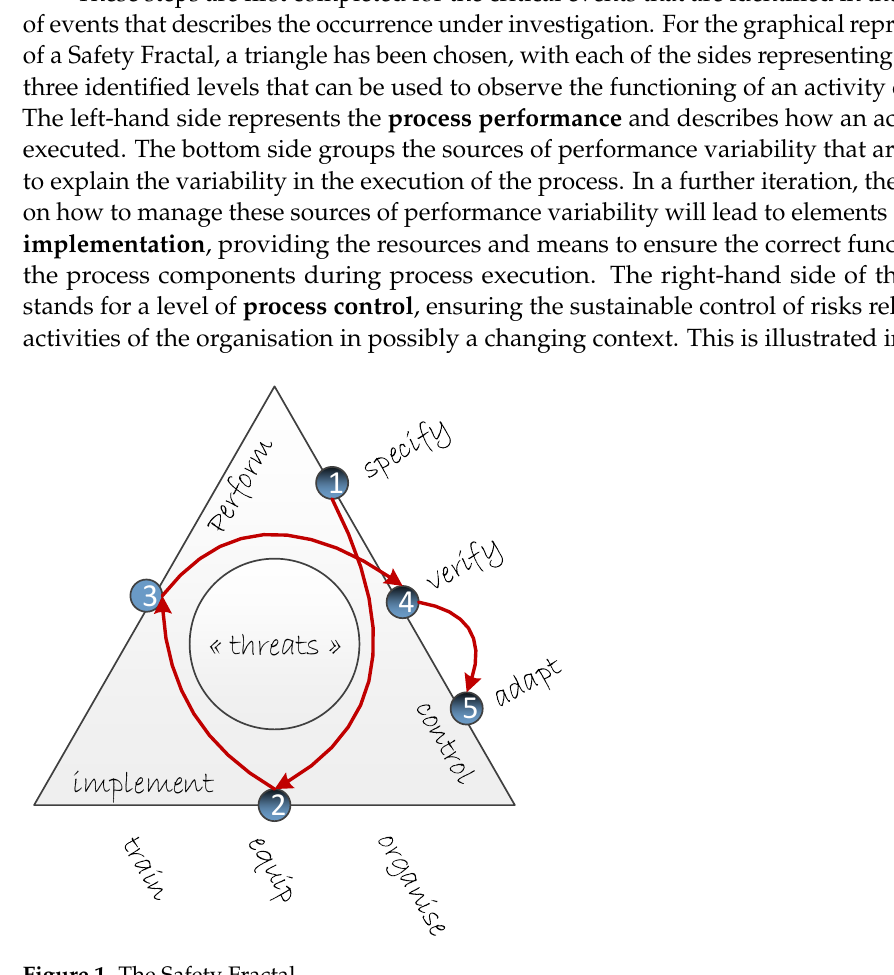
Figure 1. The Safety